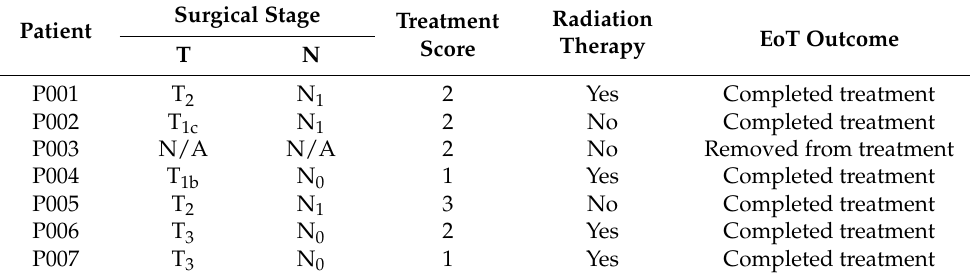
Table 1. Summary of patient outcomes by the end of treatment (EoT).